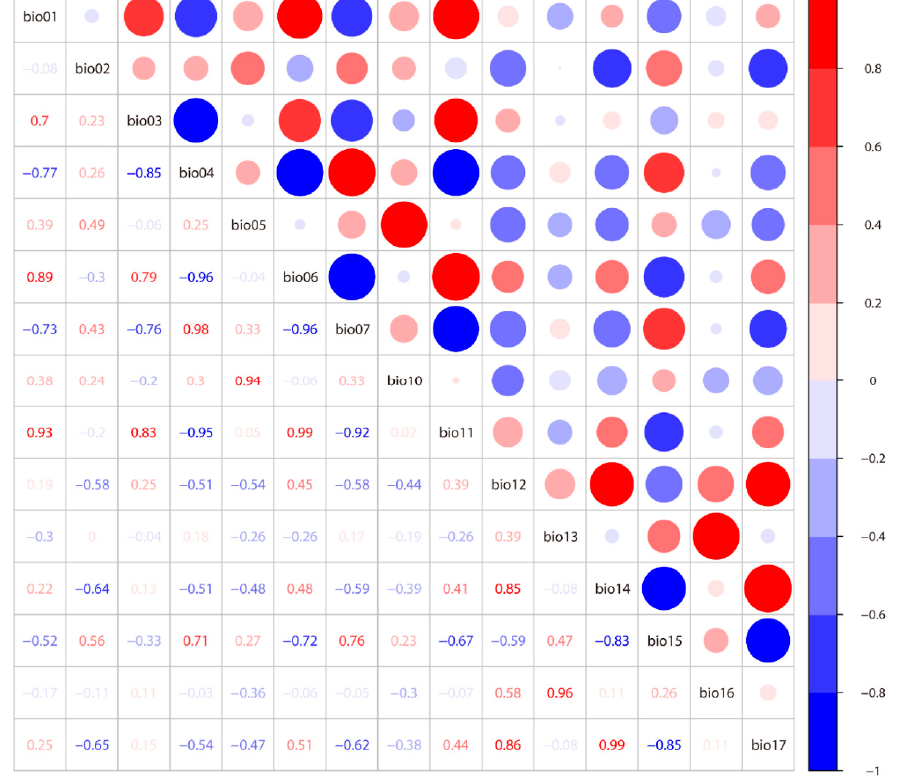
Figure 1. Correlation analysis of 15 bioclimatic variables. Red represents positive correlation, blue represents negative correlation, and the darker the color, the stronger the correlation. The size of the circle represents the strength of the correlation, and the larger the circle represents the stronger the correlation. These values are correlation coefficients.